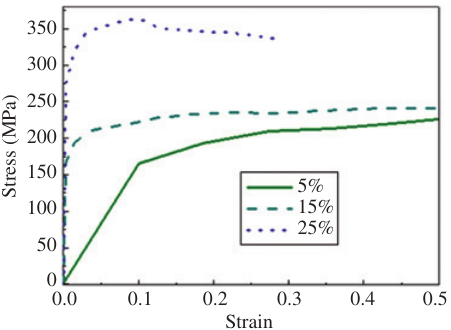
Figure 4 Stress-strain behaviors of SiCp/Al composites with differ- ent SiC particle volume